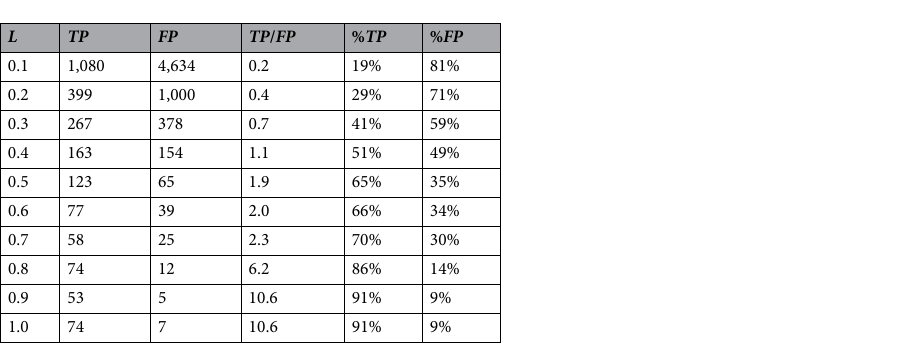
Table 4. True-positive and false-positive target predictions for the test set of 745 approved drugs grouped by the reliability score L. From L ≥ 0.4, TP is higher than FP. Importantly, %TP is strongly correlated with the reliability score